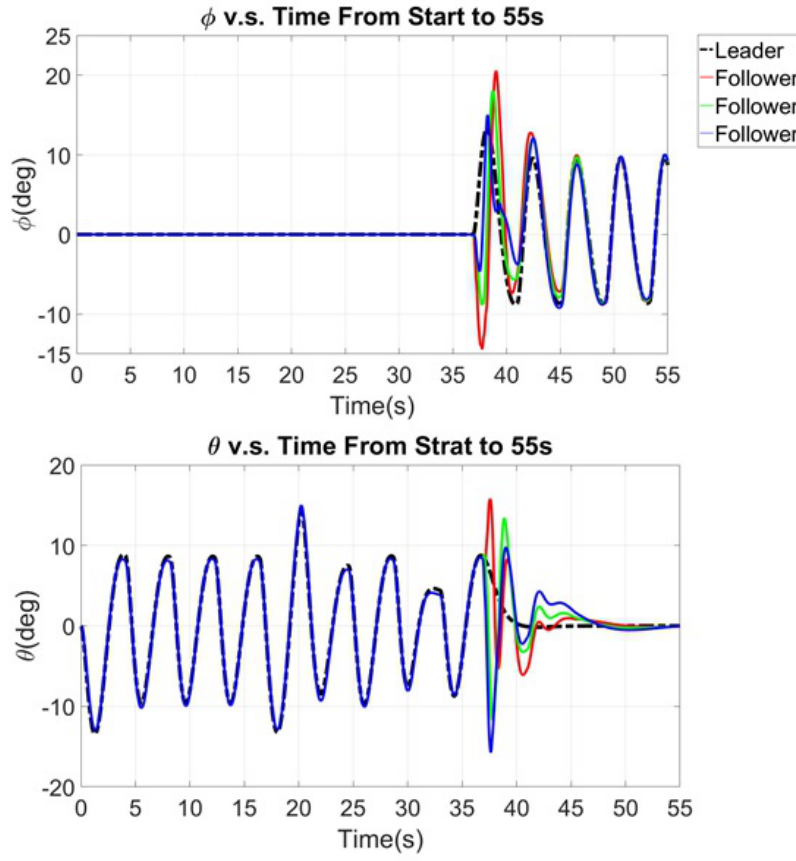
Figure 20. Responses of pitch and roll angles from start to 55